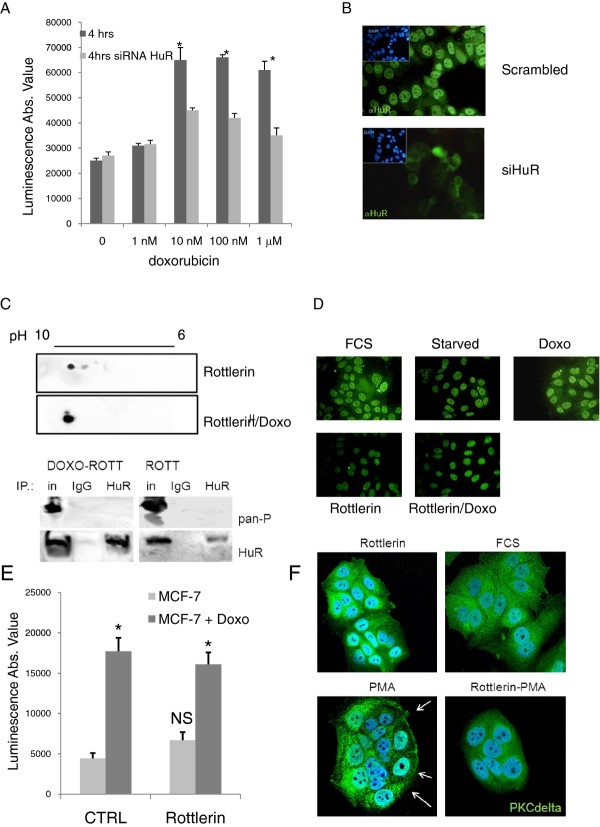
A: HuR is necessary for caspase 3/7 activation doxorubicin induced. Histogram shows the caspase 3/7 activation (as luciferase intensity) in MCF-7 cells in the presence of increasing doxorubicin concentration with (light grey bar) or without (dark gray bar) HuR silencing. Graph of a representative experiment out of three experiments. Experiments were run in quadruplicate. * p-value < 0.01 with respect to HuR silenced cells. B: HuR silencing. Immunofluorescence on MCF-7 cells at 24 h after the siRNA HuR transfection. HuR is represented in green, counterstaining DAPI is blue. C: Doxorubicin induced HuR phosphorylation is blocked by rottlerin. 2D gel western blots on whole MCF-7 cell lysates cells treated with Rottlerin 10 mM for four hours and in co-administration with doxo. HuR immunoprecipitation blotted with anti HuR and pan anti-phospo antibodies. As negative control IgG immunoprecipitation was blotted with anti HuR and pan anti-phospo antibodies. In: Input material, IgG: IgG immunoprecipitated material, HuR: anti-HuR immunoprecipitated material. The drug was tested for its capacity to modify HuR phosphorylation status alone or together with doxorubicin (doxo). Control for doxo alone is shown in Figure 1E D: HuR localization. representative immunofluorescence images of HuR localization (green) in control conditions (FCS, starvation, doxo) and in the presence of Rottlerin and with pre-treatment with one hour Rottlerin and four hours doxo. Images indicate that Rottlerin blocks doxo induced HuR translocation. E. Apoptotic response activation of MCF-7. Histogram shows the caspase 3/7 activation (as luminescent intensity) of MCF-7 cells in the presence of rottlerin (light grey) or rottlerin with doxorubicin (dark gray). Graph of a representative experiment out of three experiments. Experiments were run in quadruplicate. NS, Not Significant with respect to control (CTRL), * p-value < 0.01 with respect to doxorubicin treatment. F. Rottlerin blocks PMA induced PKCδ activation. representative confocal immunofluorescence images of PKCδ localization (green) in control conditions (FCS, rottlerin, PMA) and in the presence of coadministration of Rottlerin and PMA. Images indicate that Rottlerin blocks PMA induced PKCδ membrane translocation, known mechanism of PKCδ activation.